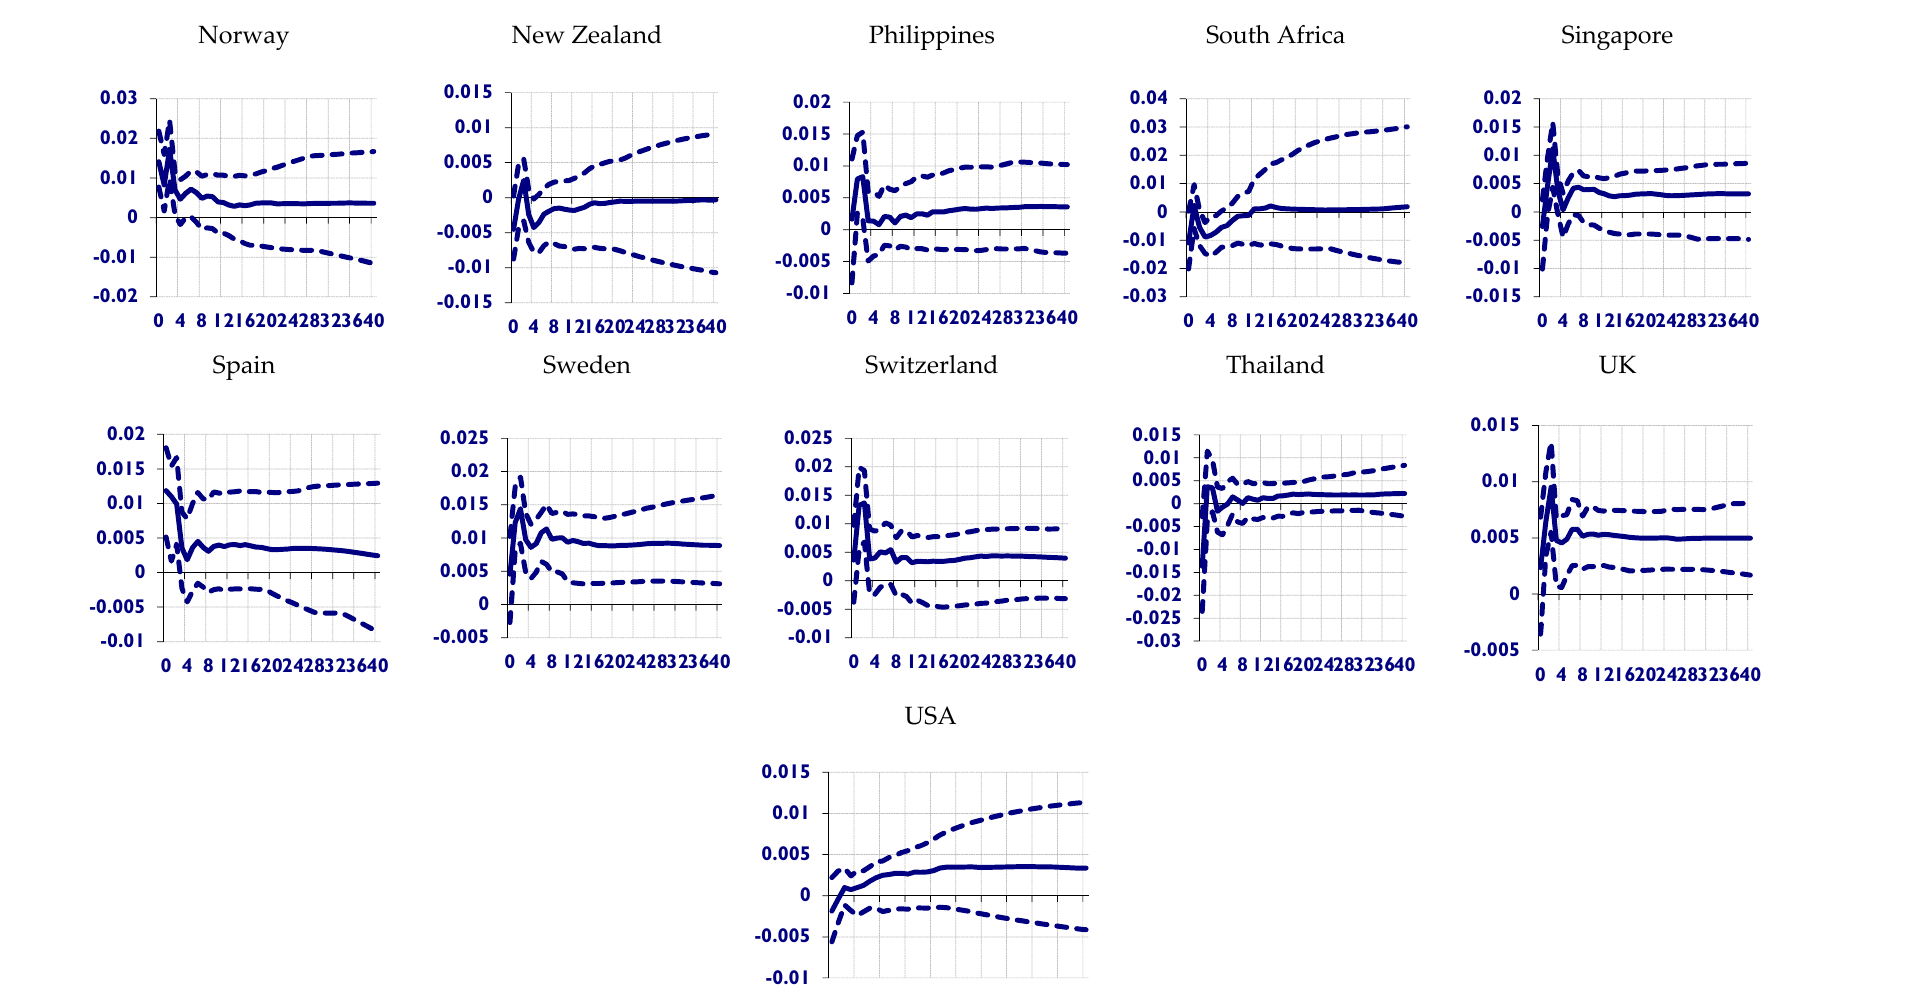
Figure 3. Group Impulse Response Functions of Real Equity Prices to a One Standard Deviation Positive US Global Technology Shock (GTS − OECD).